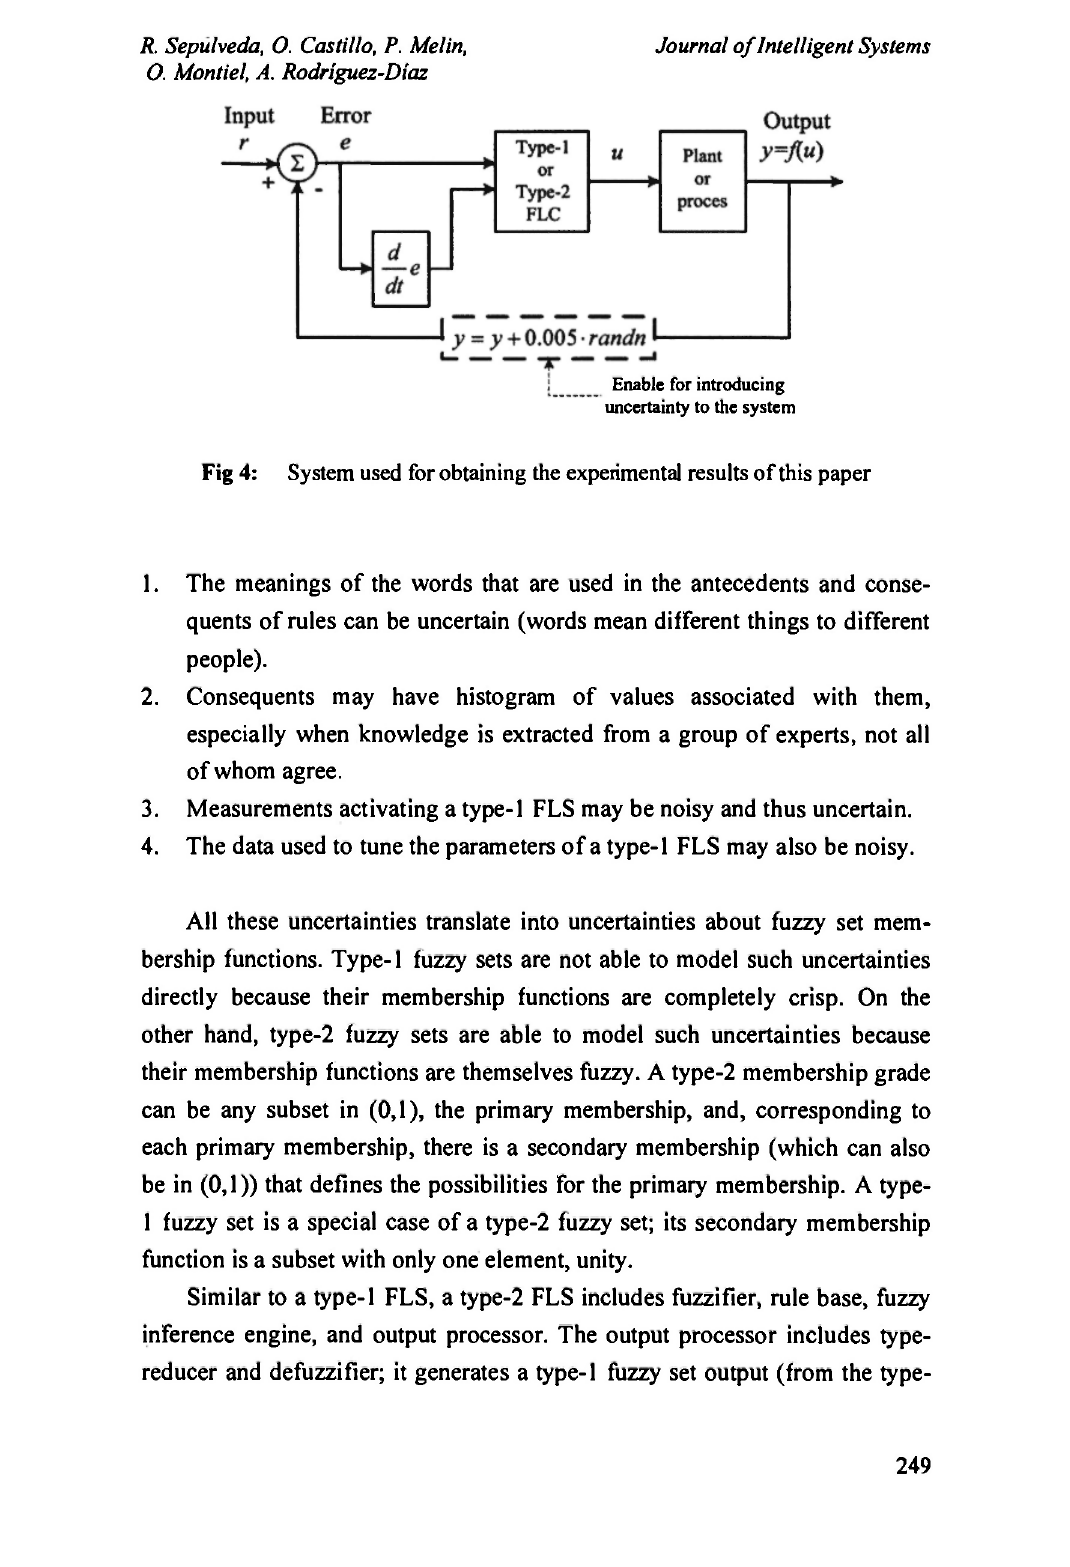
Fig 4: System used for obtaining the experimental results of this